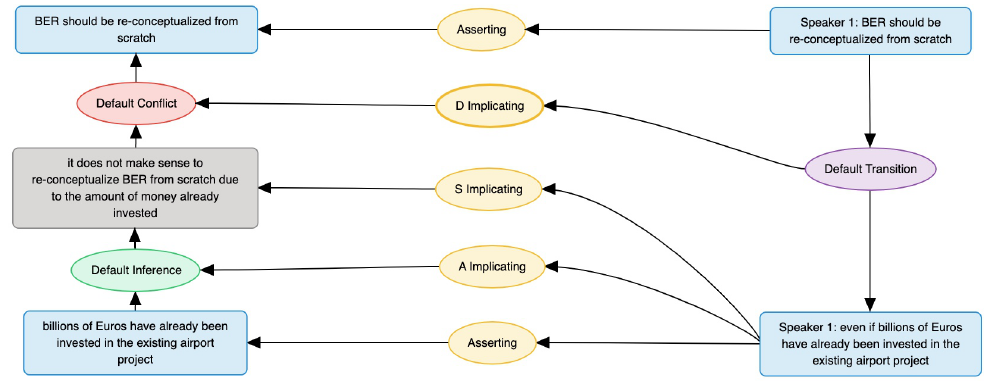
Figure 5. IAT CI diagram for Example